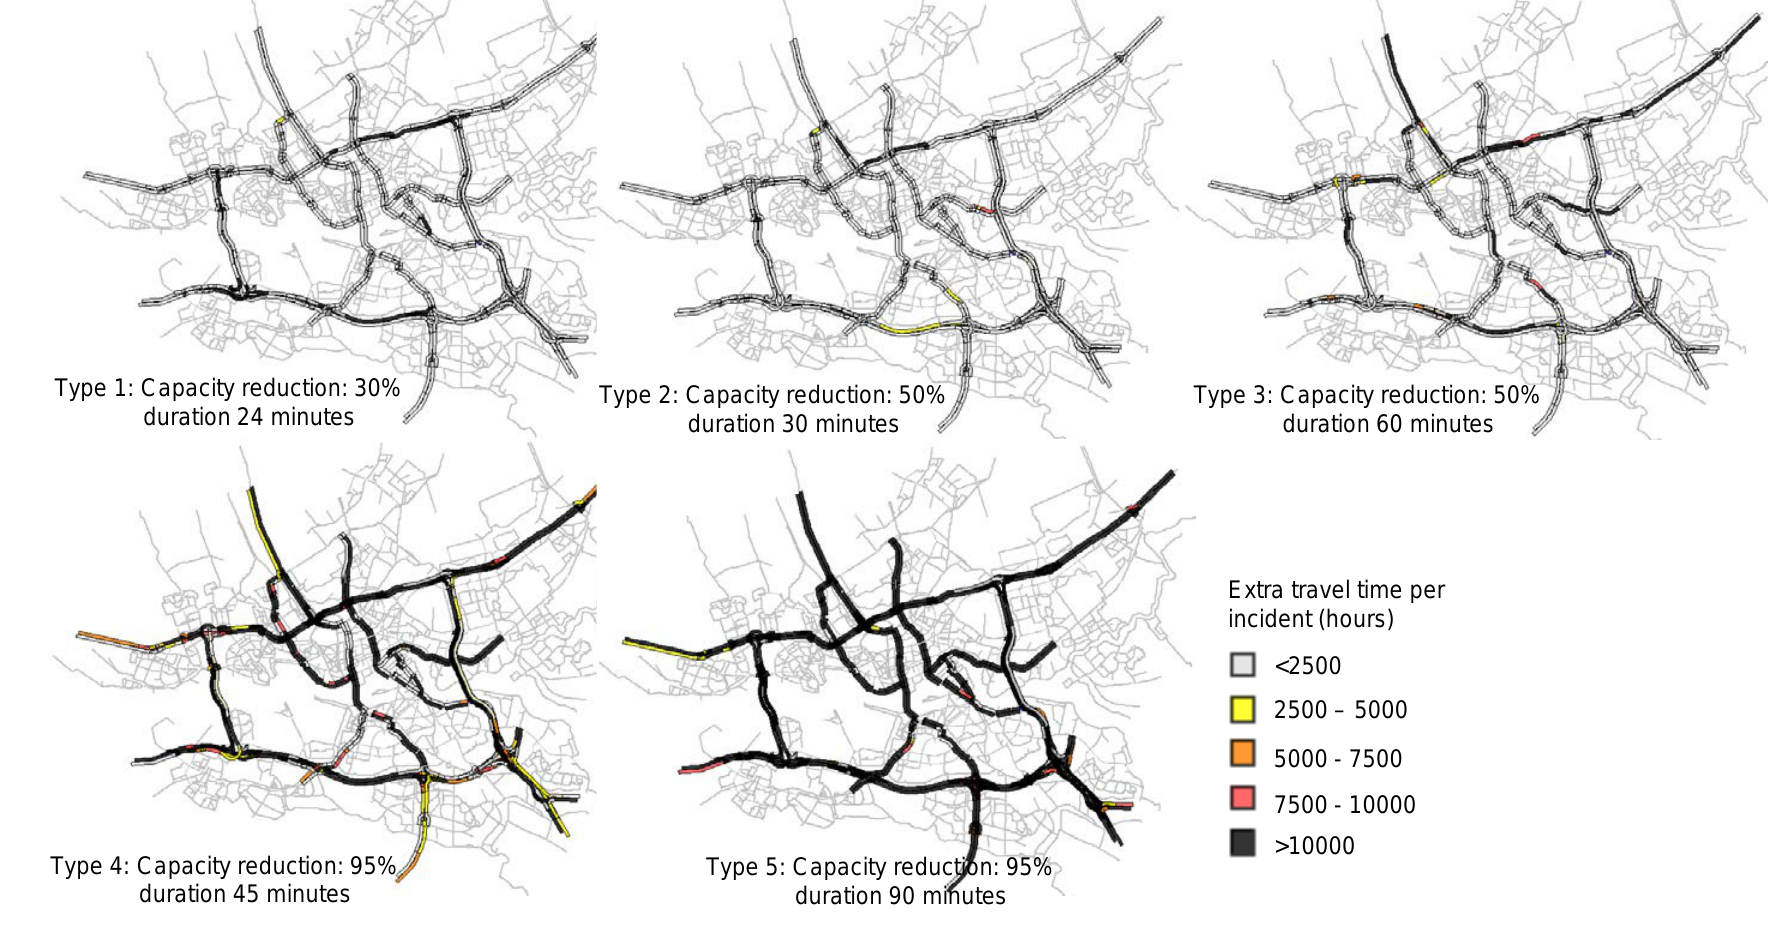
Figure 3. Extra travel time per local weather related